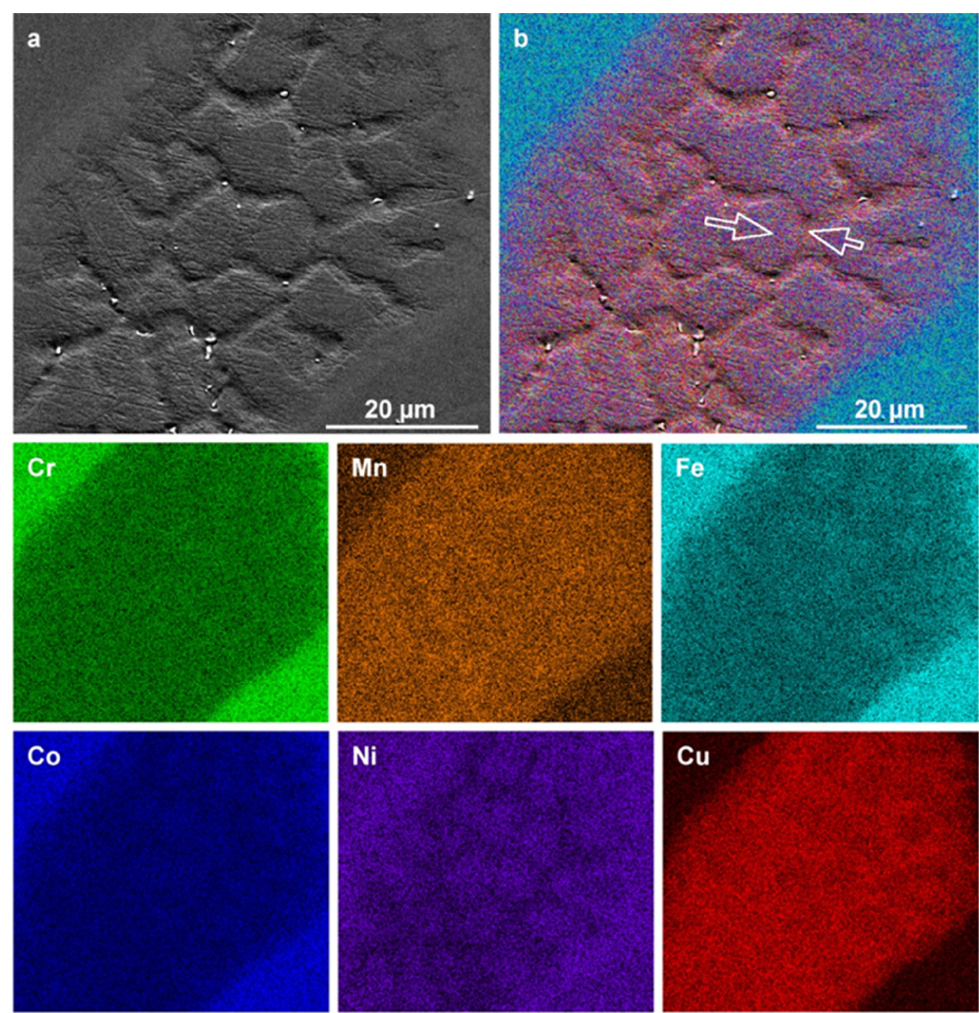
Figure 6. Morphology and elemental maps of a heat-treated CrMnFeCoNiCu alloy, focusing on a Cu-rich zone. ( a ) SEM micrograph and ( b ) corresponding layered EDS map and constituent elemental maps of Cr, Mn, Fe, Co, Ni, and Cu, respectively. Arrows indicate a region exhibiting compositional and morphological